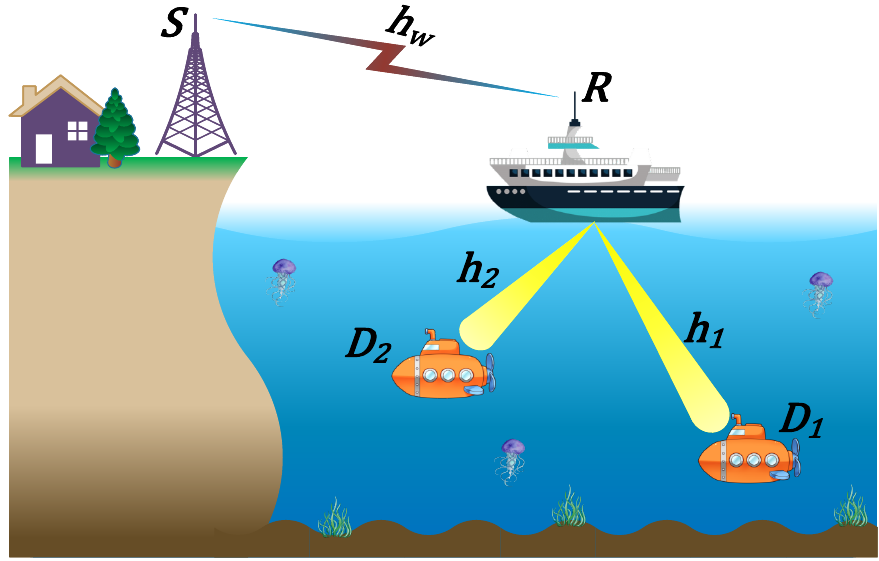
Figure 1. Downlink NOMA-based hybrid RF-UOWC system